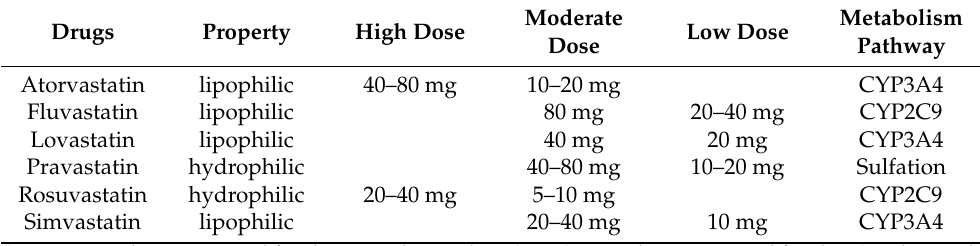
Figure 2. The effects of statins on anti-tumor progression and tumor microenvironment (TME). TME includes immune cells and MSCs. Green arrows represent inhibitory effects, and red arrows repre- sent promoting effects. 5.2. Statins in Cancer The most investigated statin in cancer is simvastatin. In general, the role of statins was tumor suppressor. Statins could induce cancer cell apoptosis through traditional